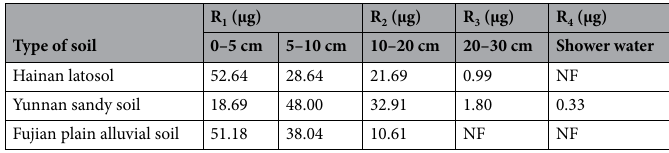
Table 5. The content distribution of fluopyram in different soil